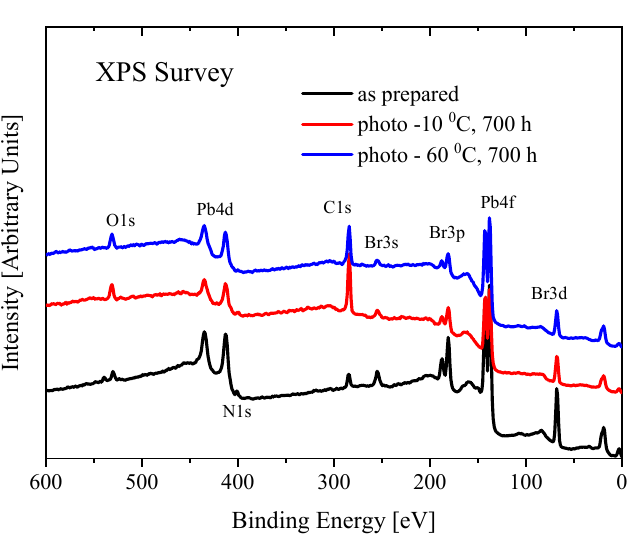
Figure 4. XPS survey spectra of MAPbBr 3 before and after light soaking at different temperatures. Table 1. Surface composition (in at. %).